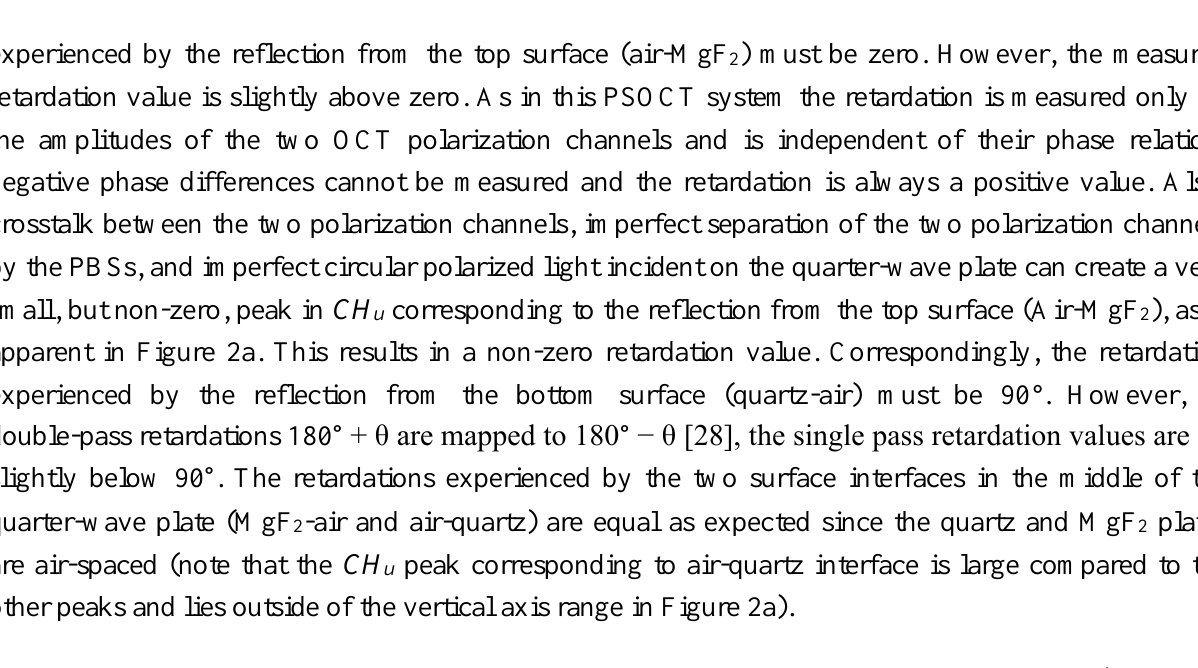
Figure 2. PSOCT imaging of a quarter-wave plate; Measured OCT signal amplitudes ( CH u and CH v ) ( a ) and the retardation ( b ) of an achromatic quarter-wave plate; ( c ) change in the retardation with axial depth, and ( d ) change in the retardation with the orientation of the achromatic quarter-wave plate optic